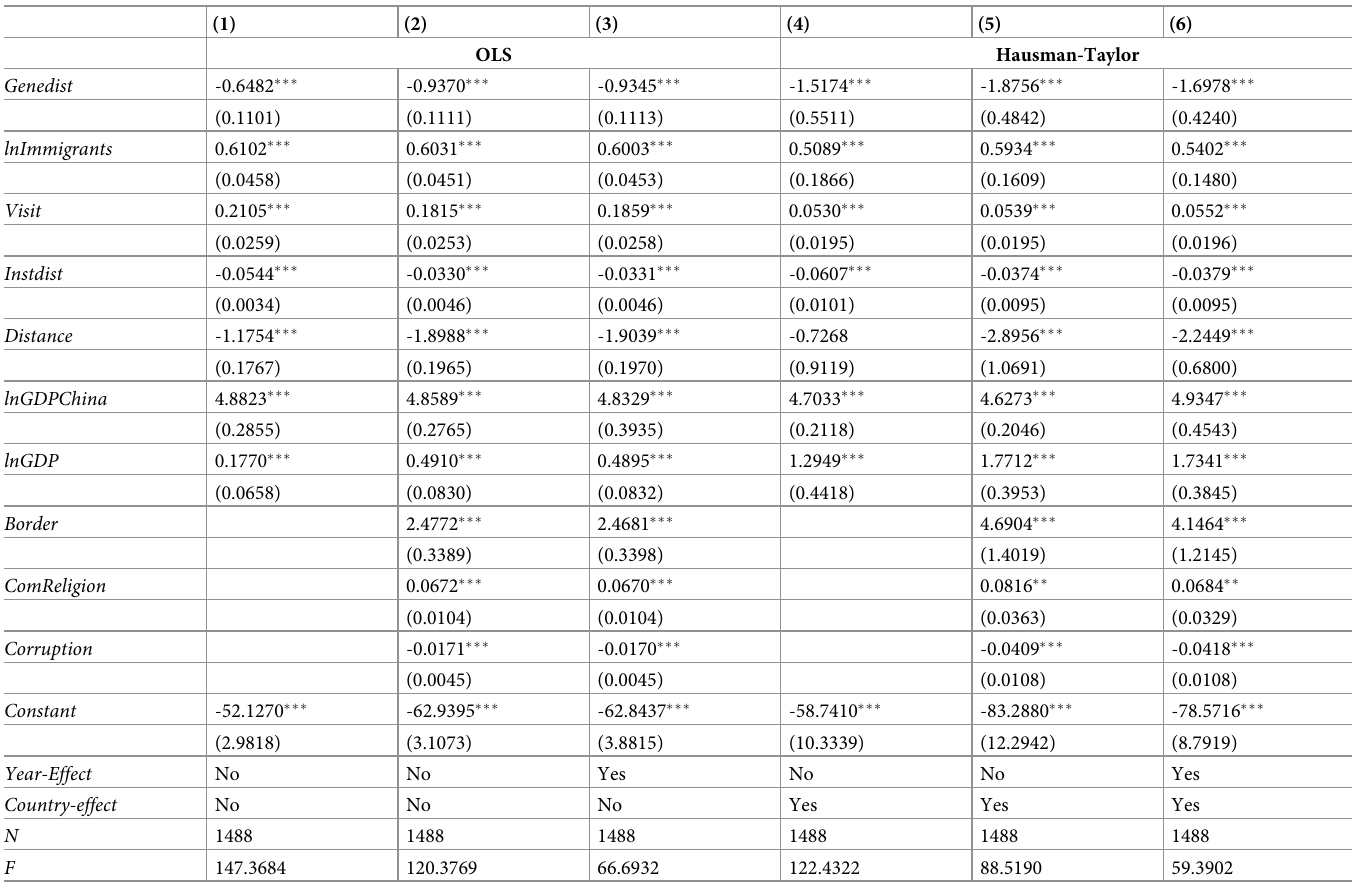
Table 8. The impact of “intimate” relations on China’s OFDI in energy sector: Using alternative explanatory